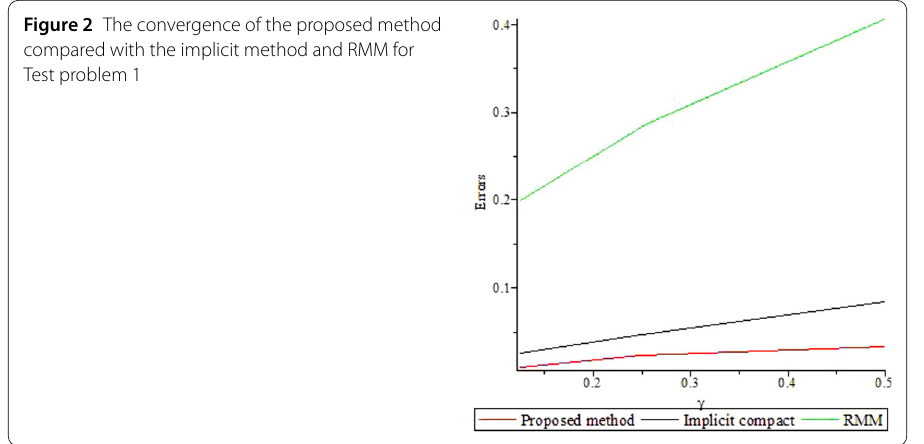
Figure 2 The convergence of the proposed method compared with the implicit method and RMM for Test problem 1